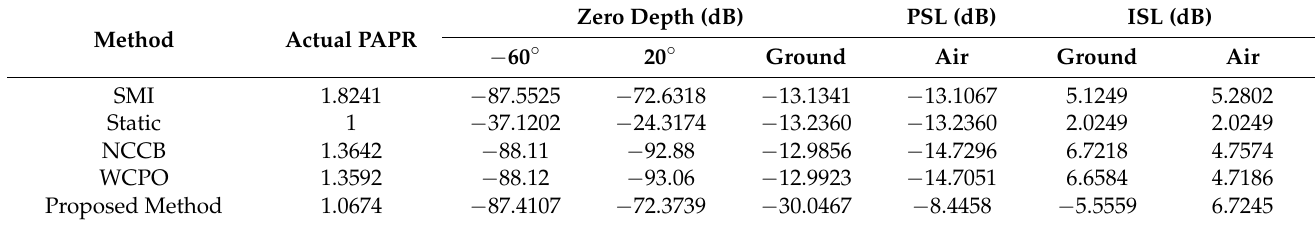
Table 2. Comparisons on the performances of the PAPR, zero depth, PSL, and ISL for different